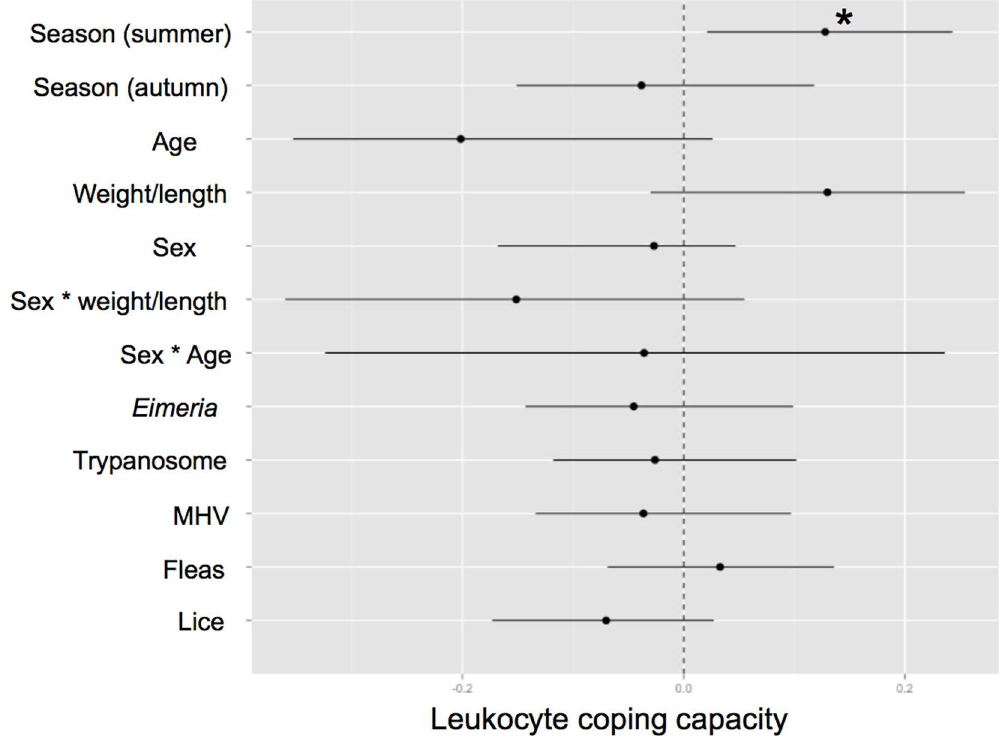
Fig 2. Model averagedparameterestimates and their 95% confidence intervals for the predictors (season, age, weight/length ratio, sex, sex * weight/length, sex * age, and infection intensity of five pathogens) associated with the leukocyte coping capacity. * indicates a parameter with a significant